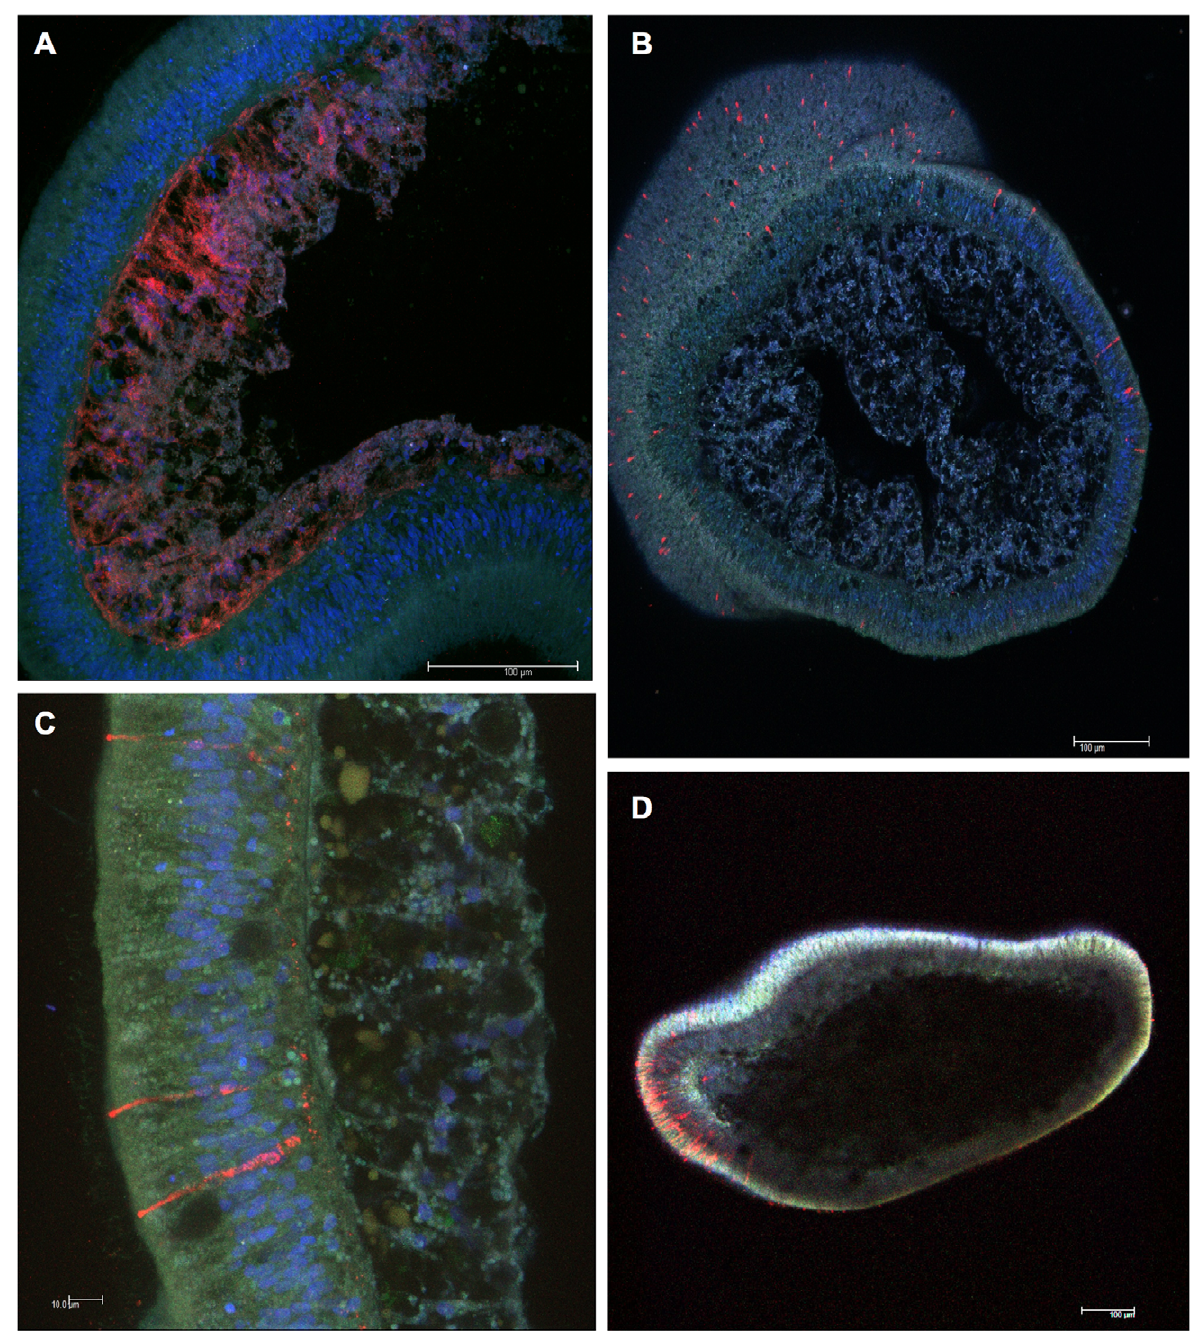
Figure 3. Localization of acropsins 1 and 2 in A.palmata larvae. Planulae were fixed, sectioned, probed with anti-acropsin antibodies as described in Materials and Methods. Laser confocal microscopy shows localization of the immunofluorescence (secondary antibody, Cy3, red), endogenous green fluorescence, and DAPI staining of the nuclei (blue). (A) Longitudinal section of the larva probed with anti-acropsin 1 antibody. Positive labeling of acropsin 1 (red) is observed in the larval gastrodermis. Image: snapshot (single z plane); objective=40 6 ; scale bar: 100 m m. (B) Transverse cross section labeled with anti-acropsin 2 antibody showing localization of acropsin 2 in solitary epithelial cells (red). Image: maximum projection; objective=20 6 ; scale bar: 100 m m. (C) Morphology of three acropsin 2-positive cells with proximal ends terminating in the mesoglea. Image: maximum projection; objective=63 6 oil; scale bar: 10 m m. (D) Longitudinal section of the entire animal showing the predominantly aboral localization of acropsin 2-positive cells. Image: snapshot (single z plane); objective=10 6 ; scale bar: 100 m m. doi:10.1371/journal.pone.0050371.g003 regions) were selected for each Acropsin. Peptides were synthe- hemocyanin (KLH) and mixed with Complete Freund’s Adjuvant sized by Genscript and antibody production performed by for initial inoculation and Incomplete Freund’s Adjuvant for subsequent boosts. Antibodies were affinity purified using an Cocalico Biologicals. Peptides were conjugated to keyhole limpet